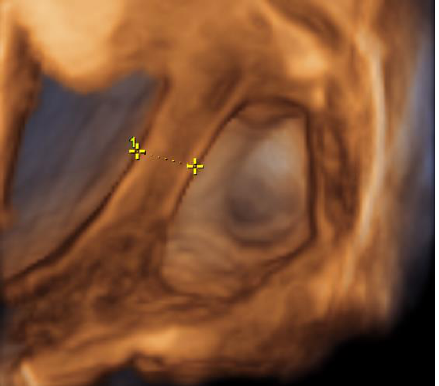
Figure 6. Left cornu of the uterus visualized by 3D transabdominal ultrasonography at the 22nd week of gestation.